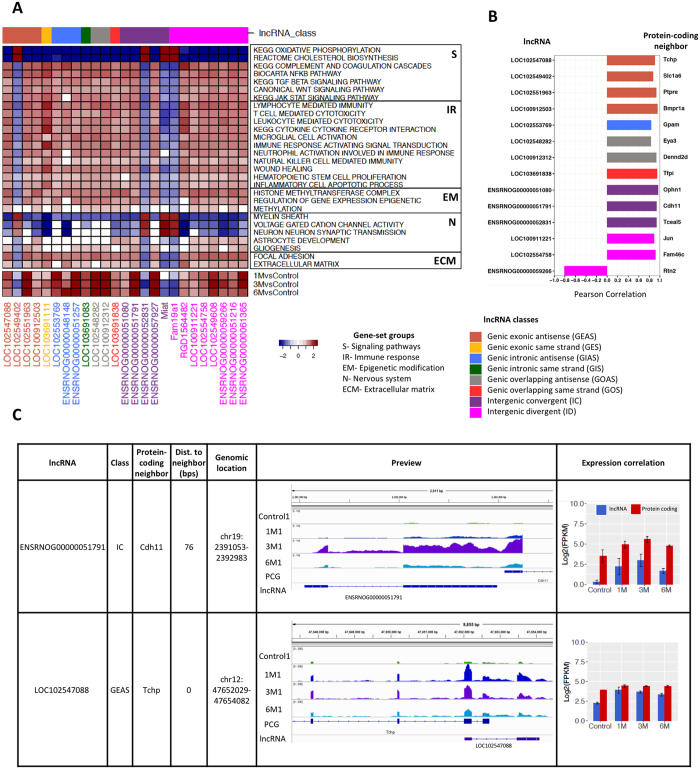
Inferring potential functions of DE lncRNAs in rat SCI.(A) Upper panel: Heatmap representing an association matrix of selected lncRNAs and enriched functional terms. Columns correspond to selected DE lncRNAs. Rows are enriched gene ontology terms and MsigDB canonical pathways. Enriched functional terms were categorized into signaling pathways (S), immune response (IR), epigenetic modification (EM), nervous system (N), and extracellular matrix (ECM). Color depth represents NES (normalized enrichment score) calculated by GSEA, indicating the association strength. Lower panel: Temporal expression assessed as log2(count fold-change) of selected DE lncRNAs. (B) Correlation coefficients between expression of DE lncRNAs and their closest protein-coding neighboring genes (see Methods). (C) Examples of DE lncRNAs and their closest protein-coding gene, with their classification and the distance to the nearest protein-coding gene neighbor indicated. The IGV browser view shows signal tracks for all time points. Bar plots indicate log2(FPKM) for protein-coding genes (red) and lncRNAs (blue). Error bars represent ± SD. PCG = protein-coding gene.